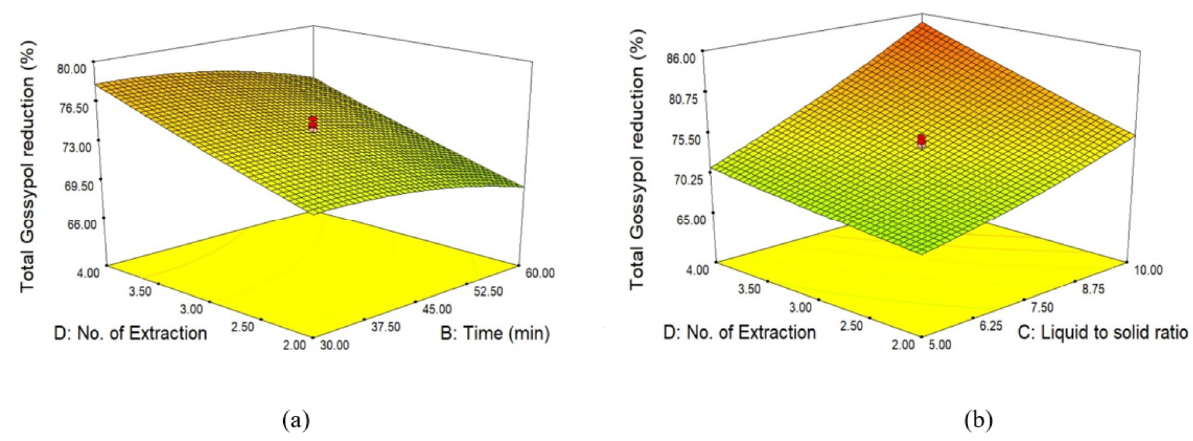
Figure 10. ( a ) 3D surface plot no. of extraction cycles and time of extraction ( b ) 3D surface plot between no. of extraction cycles and LSR.